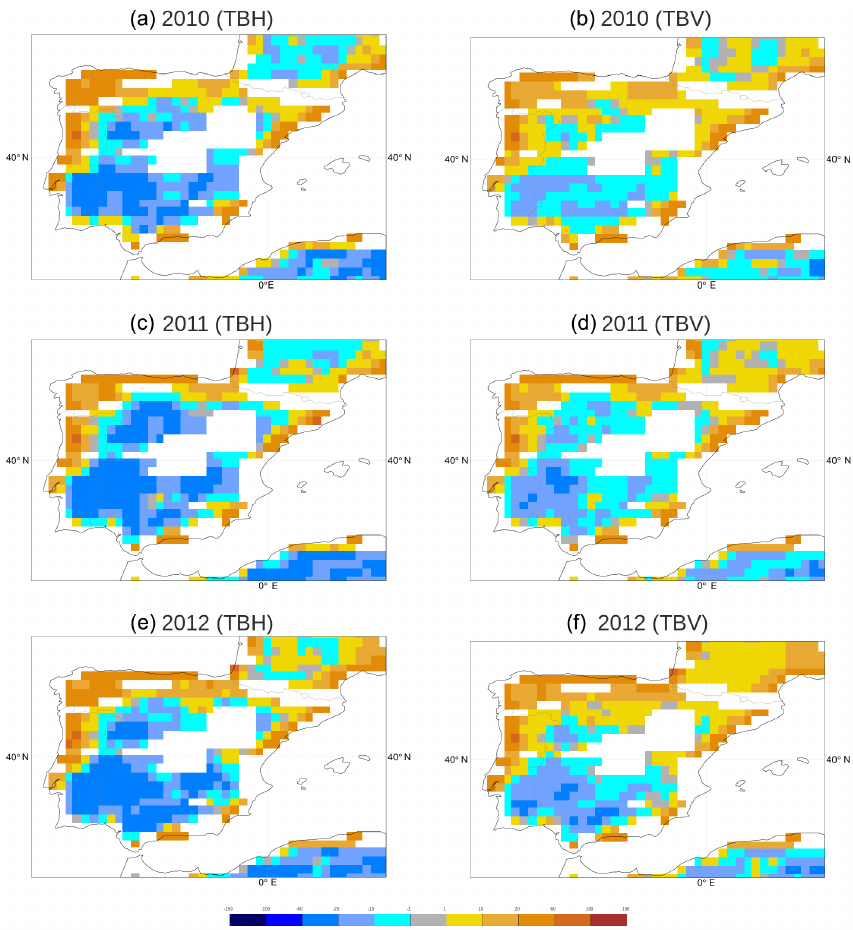
Figure 6. ECMWF’s mean error (observation–model) from the months of November 2010 to 2012. TBH and TBV correspond to the horizontal and vertical polarizations,